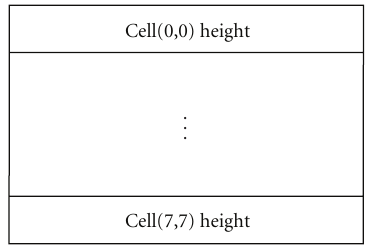
Figure 3: Chromosome for water